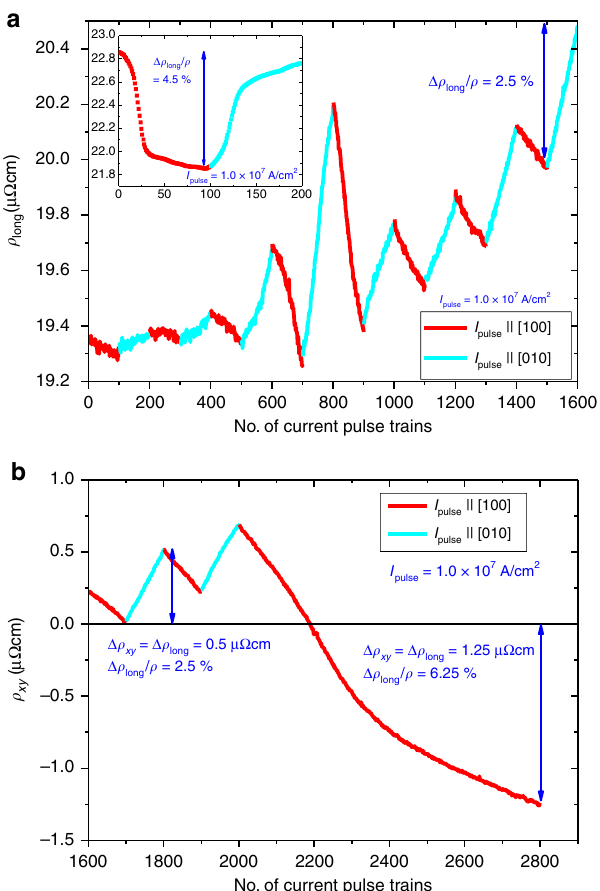
Fig. 4 Longitudinal and transversal resistivities. a Longitudinal resistivity (DC probing current density 10 4 A/cm 2 ) vs. number of applied pulse trains. The inset shows the longitinal resisitvity of another sample. In this case saturation of the magnetoresistance could be obtained for a few repetitions before the sample broke. b Transversal resistivity of the same sample as shown in the main panel of a vs. number of applied pulse trains. The crystallographic direction in which the current pulses were injected is indicated by the cyan and red color of the data